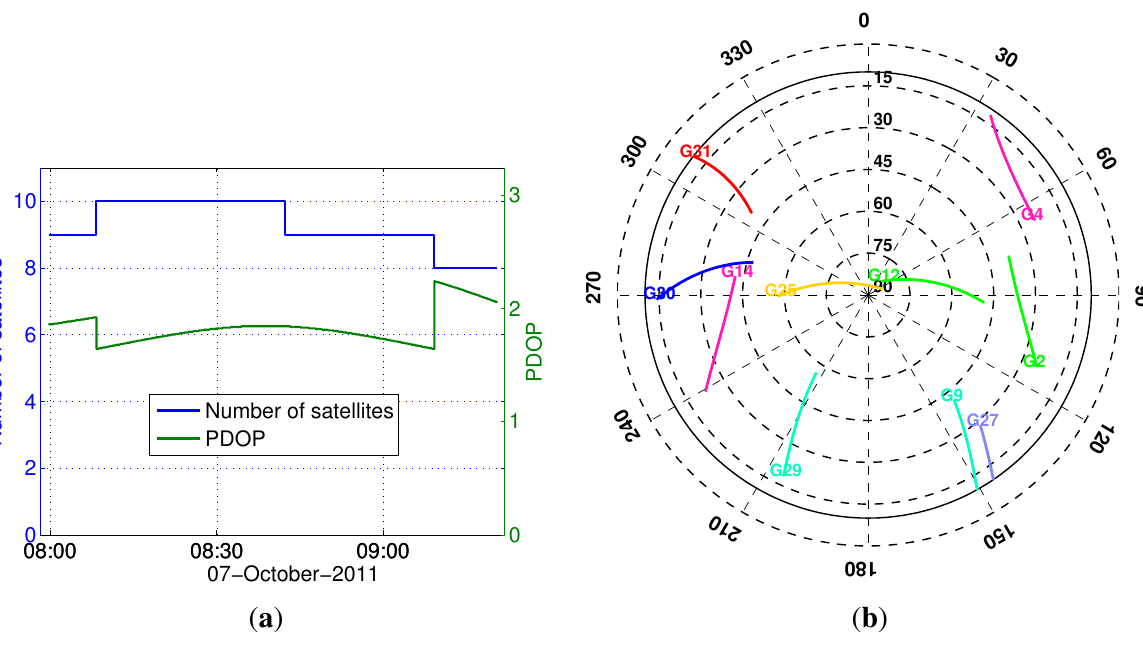
Figure 6. GPS satellite visibility during the kinematic experiment with a 10 ◦ elevation cut-off. ( a ) The number of satellites and PDOP; and ( b ) skyplot.